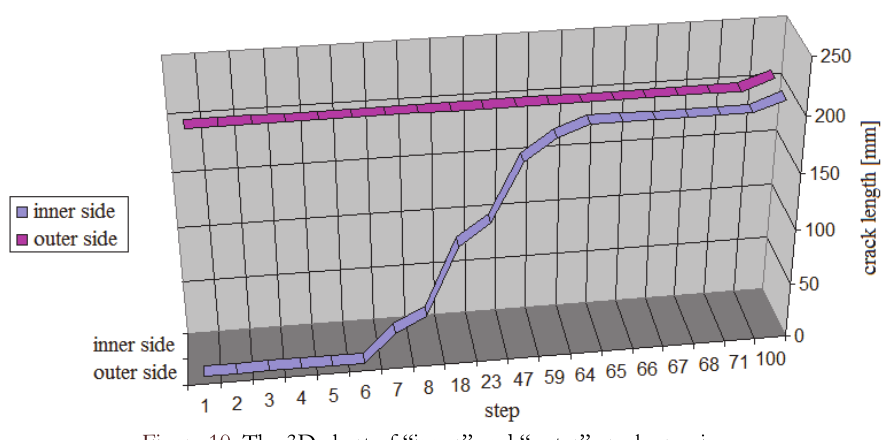
Figure 10: The 3D chart of “inner” and “outer” crack